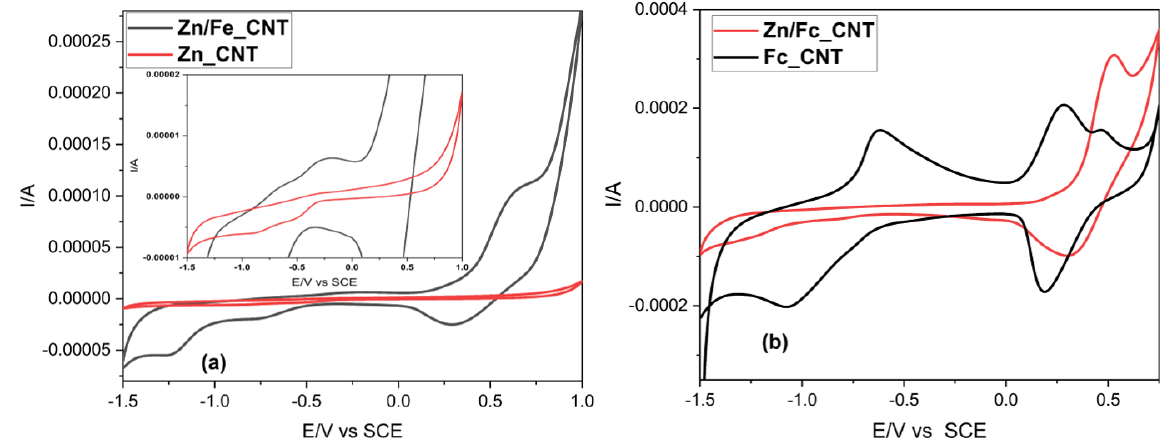
Figure 4. ( a ) CVs recorded in 0.1 M NaOH supporting the electrolyte within the potential range of − 1.5 V/SCE to +1.0 V/SCE onto the Zn/Fe_CNT paste electrode (black line) and Zn_CNT paste elec-